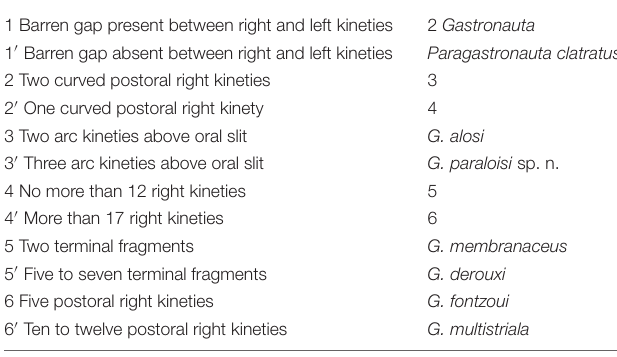
Frontiers in Marine Science |